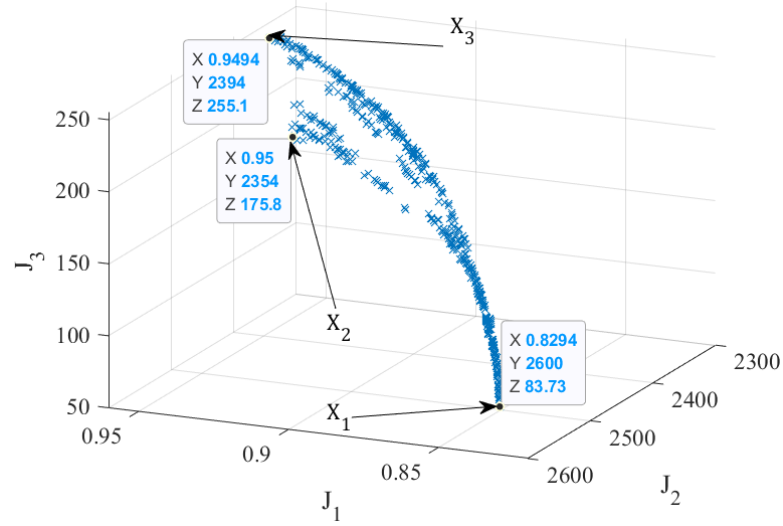
Figure 9. Pareto optimal set in the objective function space.